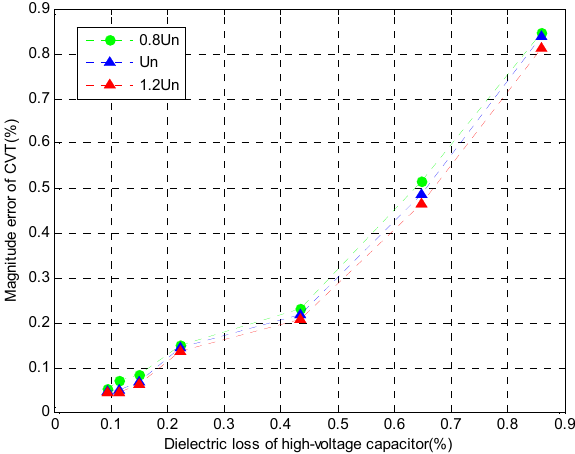
Figure 19. CVT magnitude error with different high-voltage capacitor dielectric loss factor. Plots in Figures 18 and 19 coordinate with regulations obtained from simulation. When the dielectric loss factor of high-voltage capacitor increases, the phase error is increasing in the negative direction while magnitude error is increasing in the positive direction.